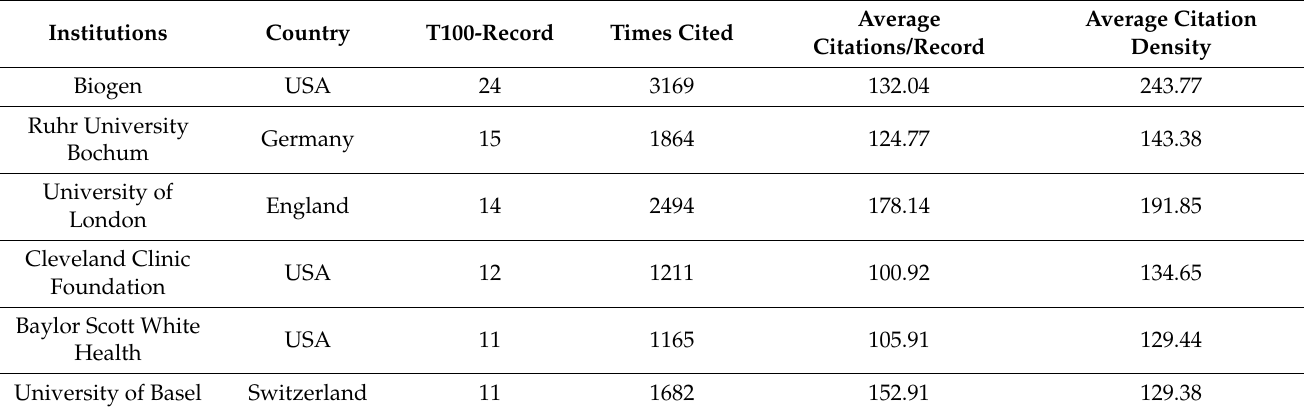
Table 4. Institutions publishing more than 10 of the T100 manuscript are arranged by the number of T100